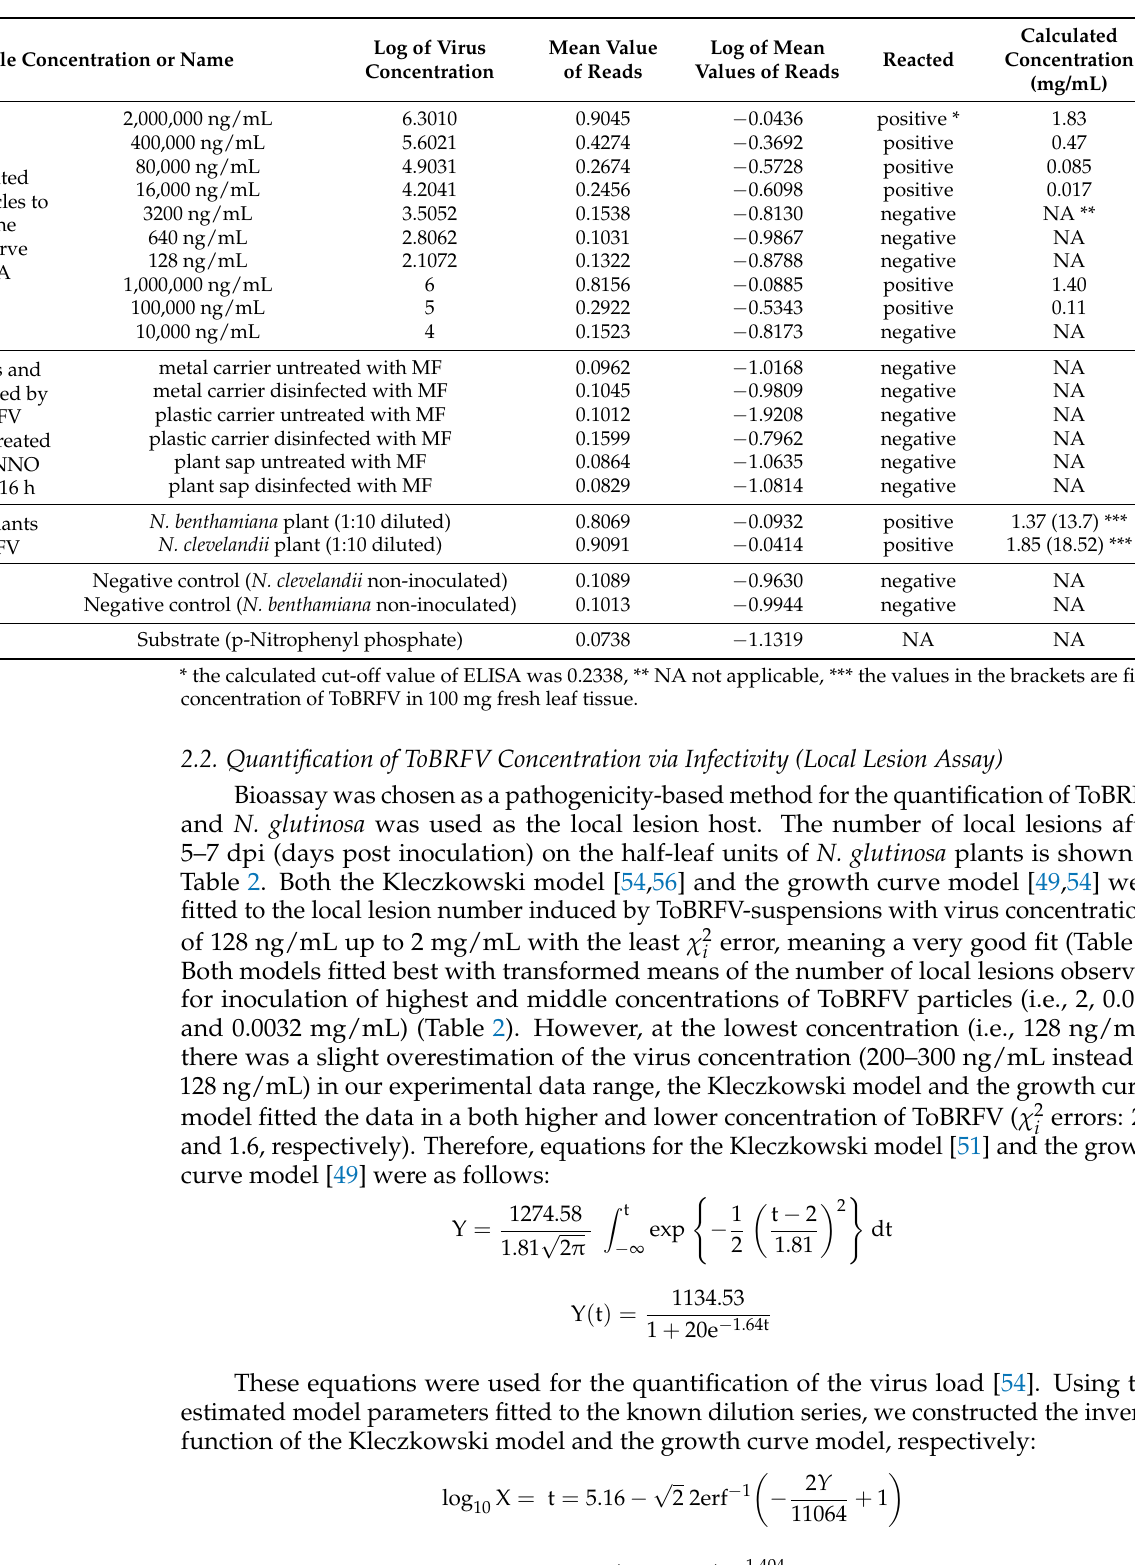
Table 1. The measured values of optical density at 405 nm (OD 405 nm ) 60 min after substrate (p-Nitrophenyl phosphate) addition.